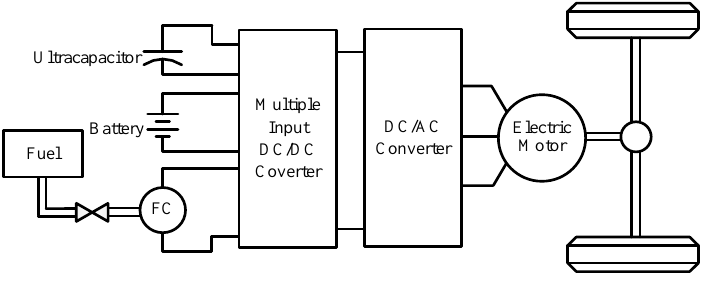
Figure 3. System configuration of fuel cell electric vehicles using multi-input DC/DC converter.